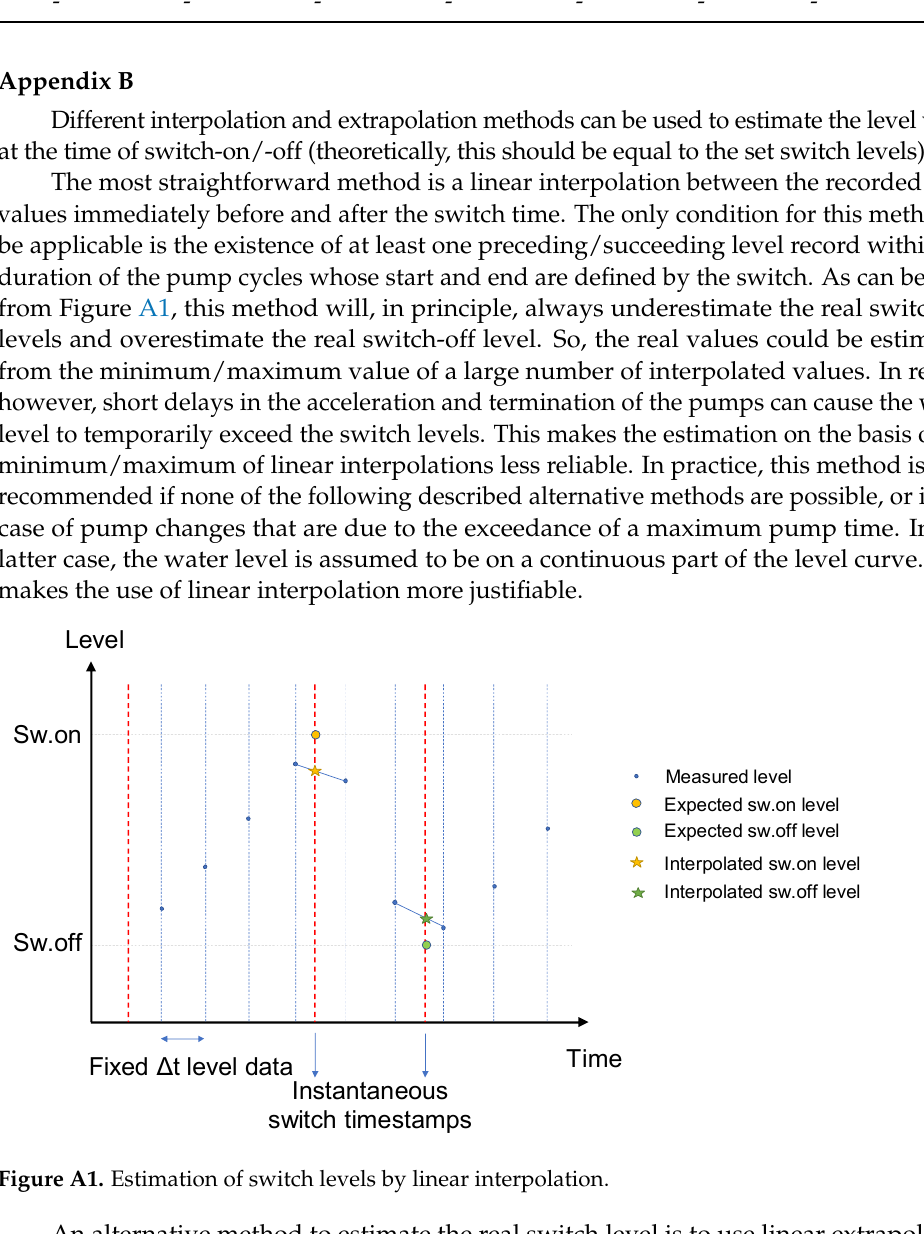
Figure A2. Estimation of switch levels by forward extrapolation.